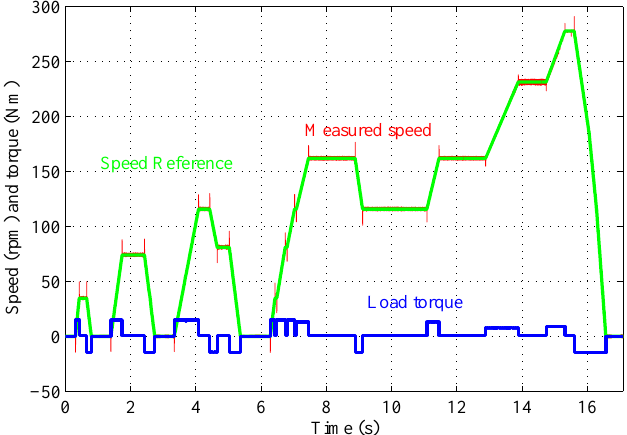
Figure 8. Speed Reference, Measured speed and absolute load torque over the proposed